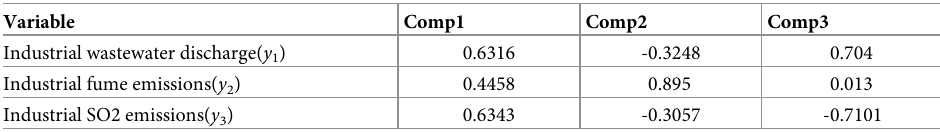
Table 4. Eigenvectors of the 3 principal pollutant emission